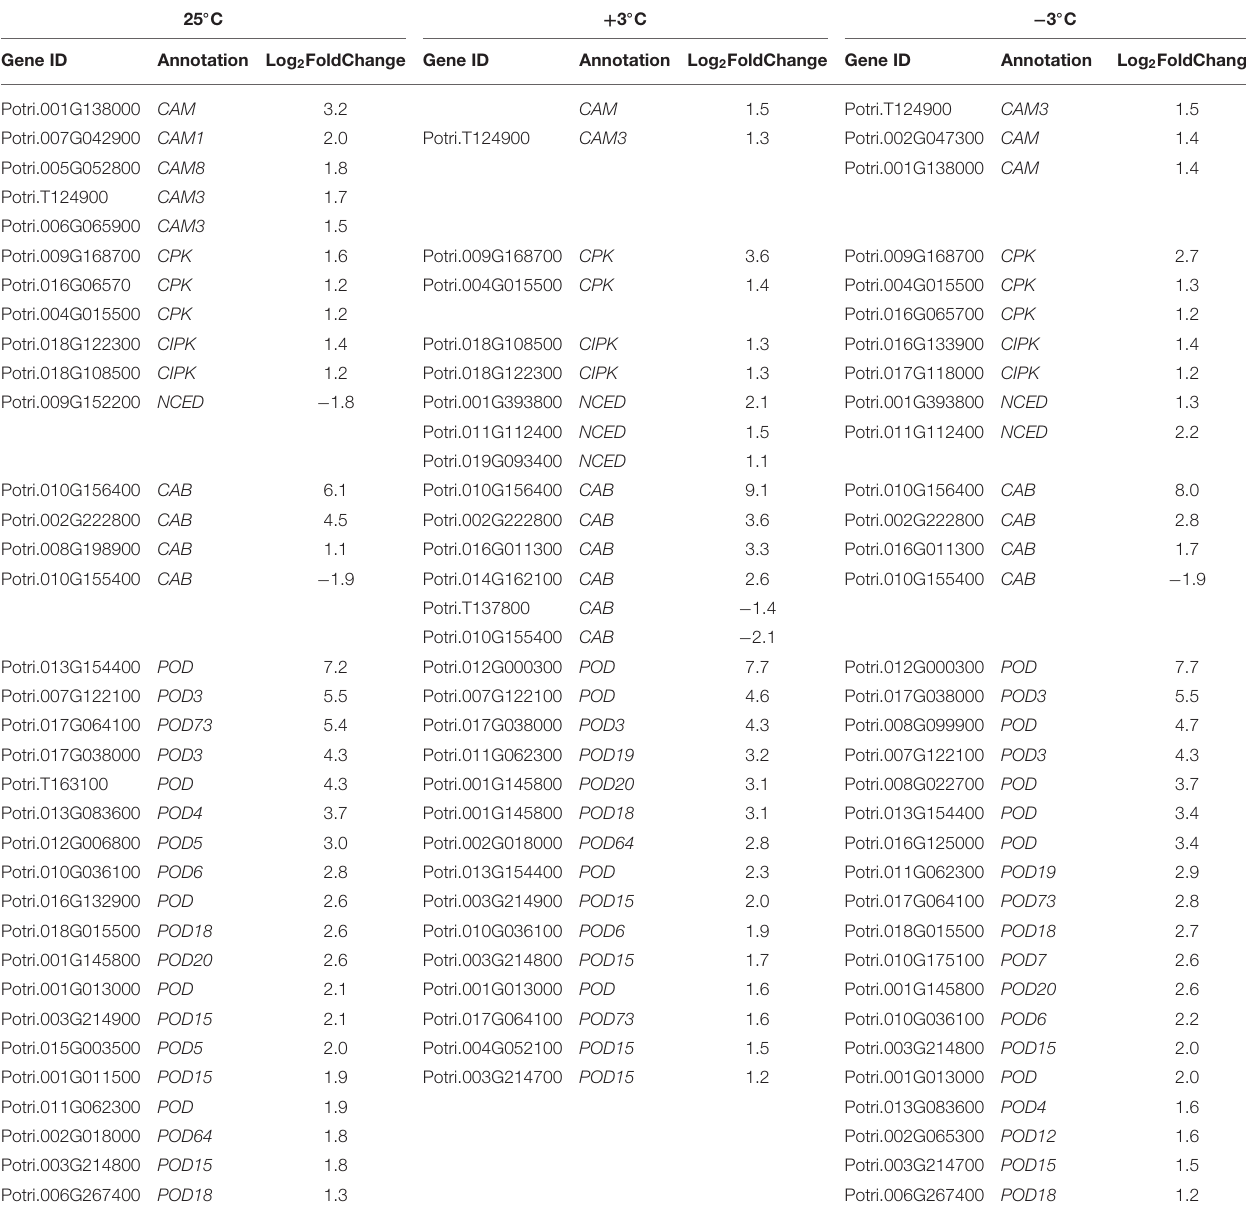
TABLE 3 | Partial differentially expressed genes (DEGs) response to cold in P. ussuriensis compared with P. trichocarpa . 25 ◦